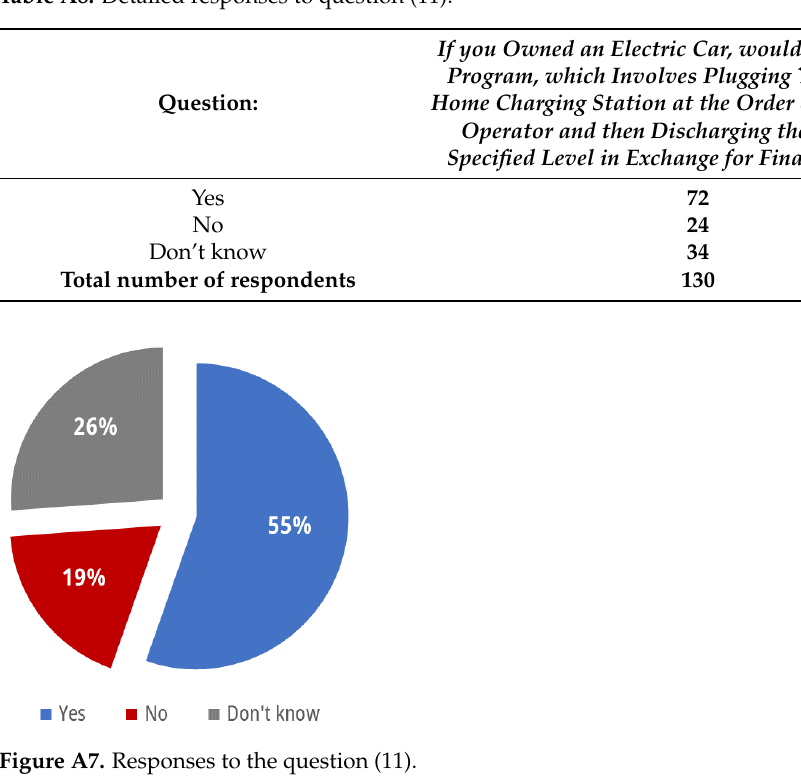
Table A8. Detailed responses to question (11).